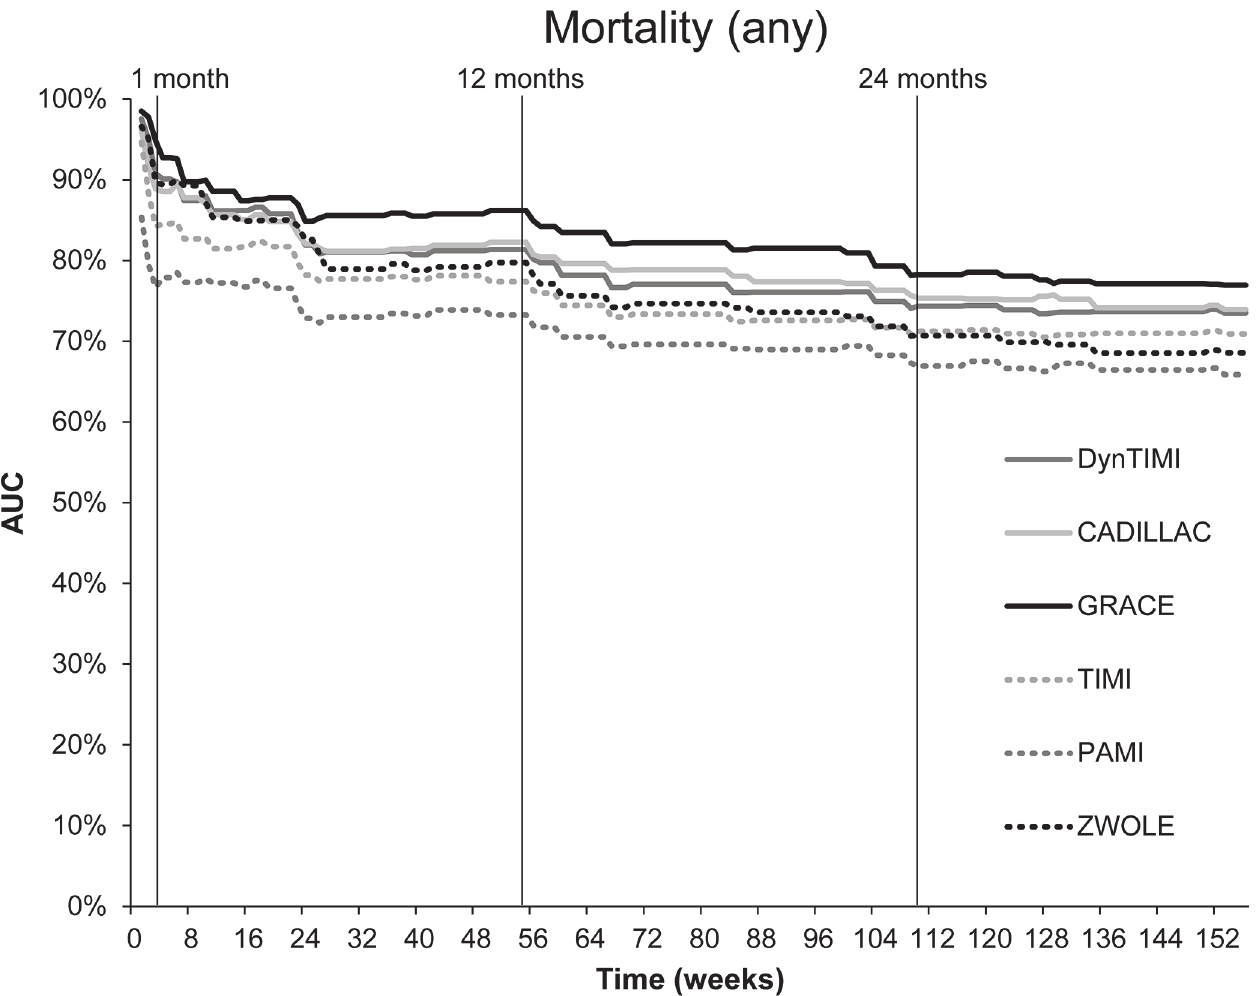
Fig 2. Predictive accuracy of scoring models for mortality during a three-year follow-up